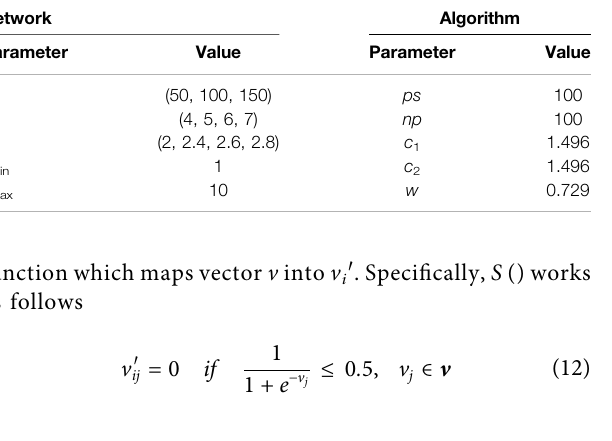
TABLE 1 | Settings of the parameters contained in the algorithm and the generated networks for testing. Network